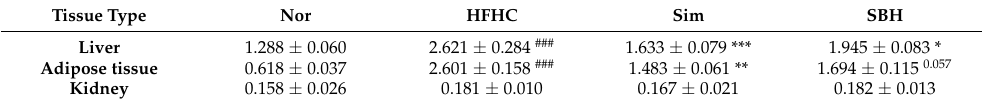
Table 2. Effect of SBH on the tissue weights in the HFHCD-induced